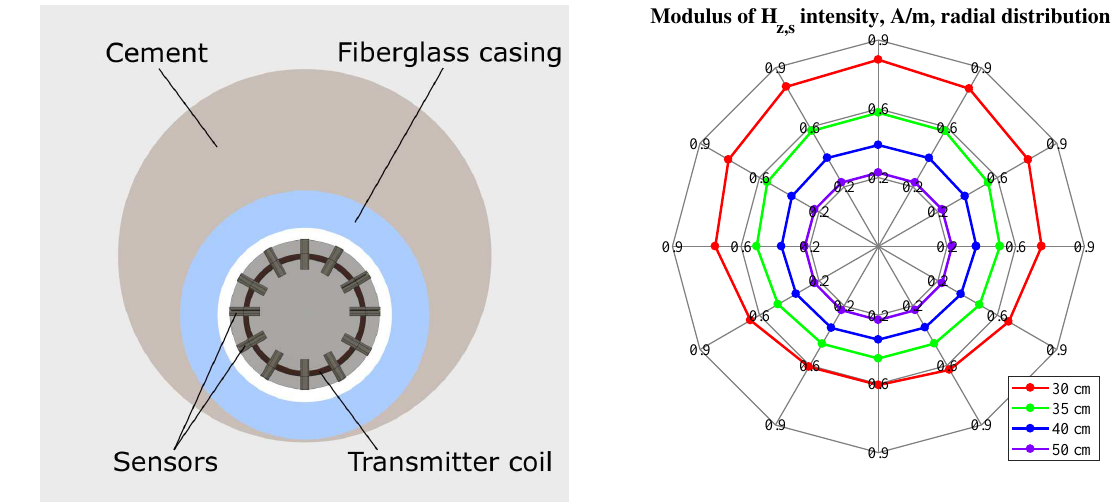
Figure 12. Facet of eccentric wellbore filled with magnetic cement. The signal frequency is 1 kHz.